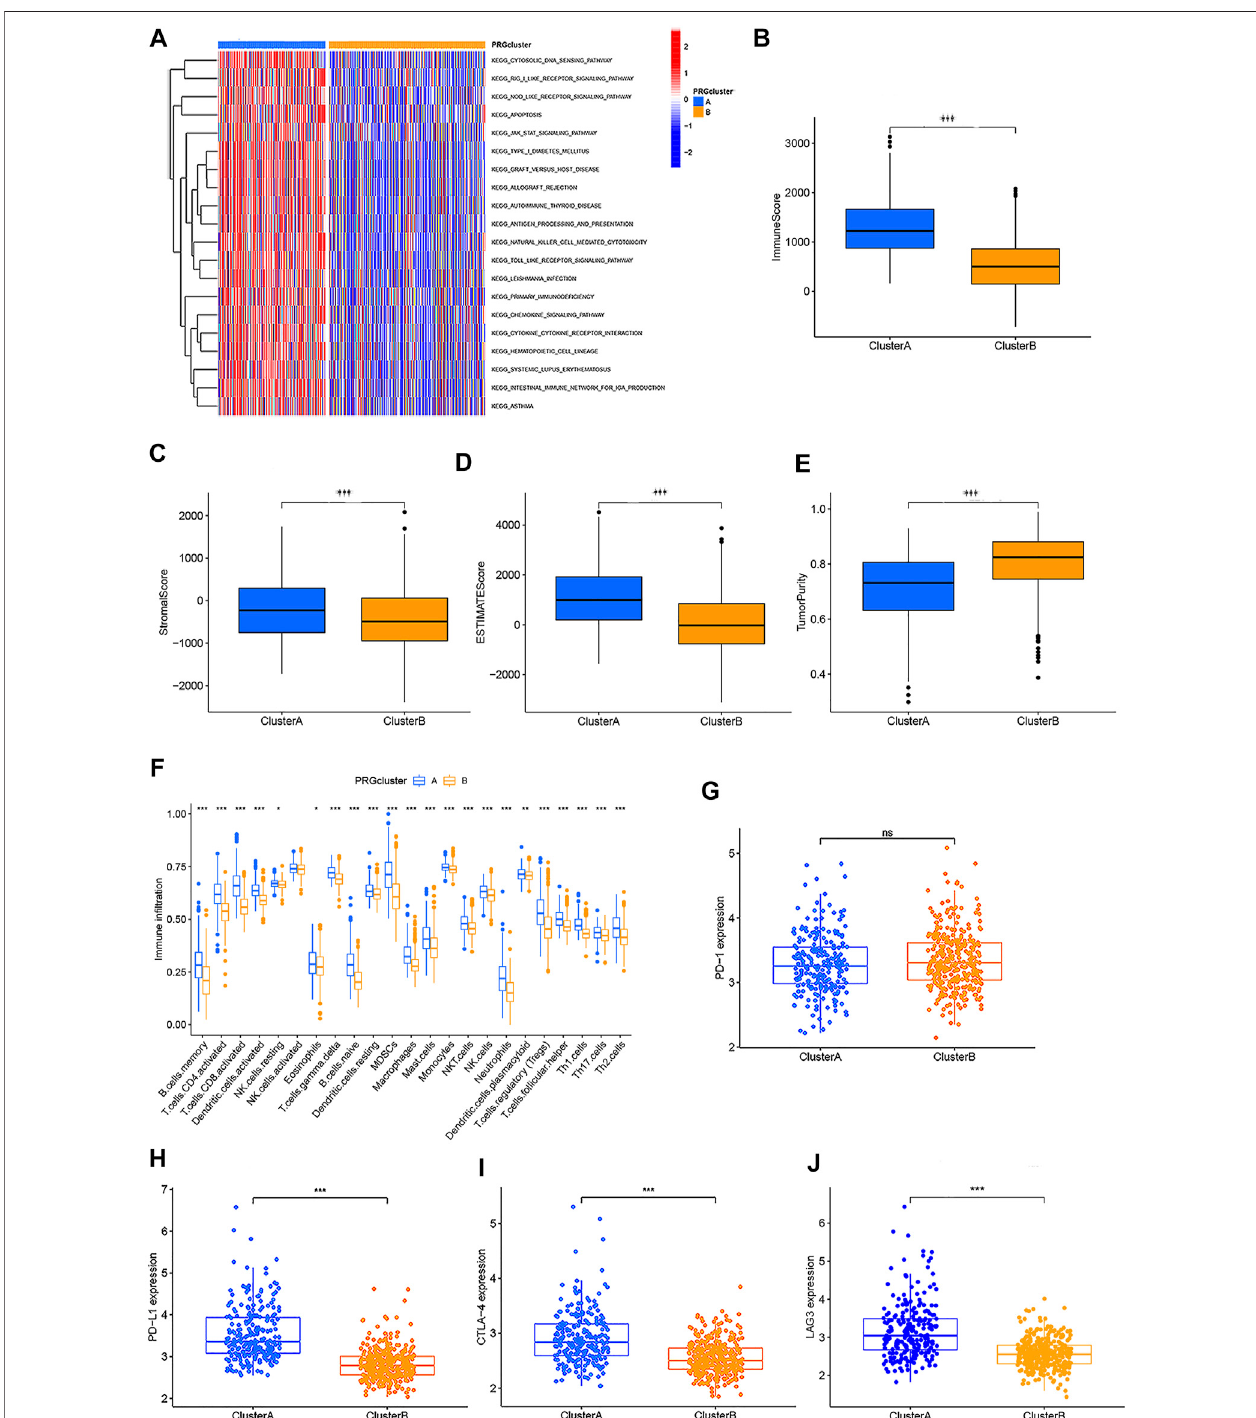
FIGURE 3 | Two different CRC subtypes showed diverse tumor immune cell microenvironments. (A) Biological processes analyzed by GSVA which showed the active biological pathways in distinct subtypes. (B – E) Expression of the TME score and tumor purity in distinct subtypes. (F) Abundance of 23 TME in fi ltrating cells between the two CRC subtypes. (G – J) Expression levels of PD-1, PD-L1, LAG3, and CTLA-4 in the two CRC subtypes. * p < 0.05; ** p < 0.01; and *** p < 0.001.